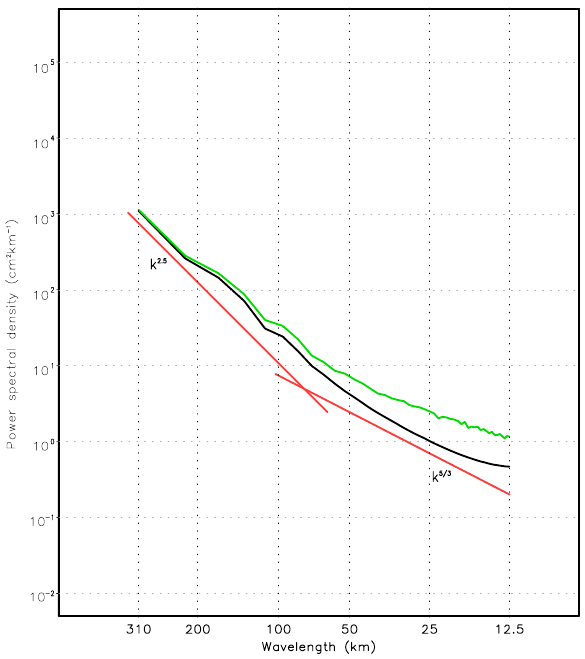
Fig. 7. The power spectrum density (cm 2 km − 1 ) as the function of the wavelength of the background (black line, experiment ATPR1; see Table 1) and the observed sea level estimate (green line). Both spectra are calculated at the same observational points along the SLA tracks in 2009. Only tracks longer than 650km were taken into account in order to reduce the effects due to the variable geometry of the Mediterranean. The observed sea level estimate is obtained by adding the MDT to the SLA. The logarithmic scale is applied on both axes. Red lines indicate the − 2.5 and − 5/3